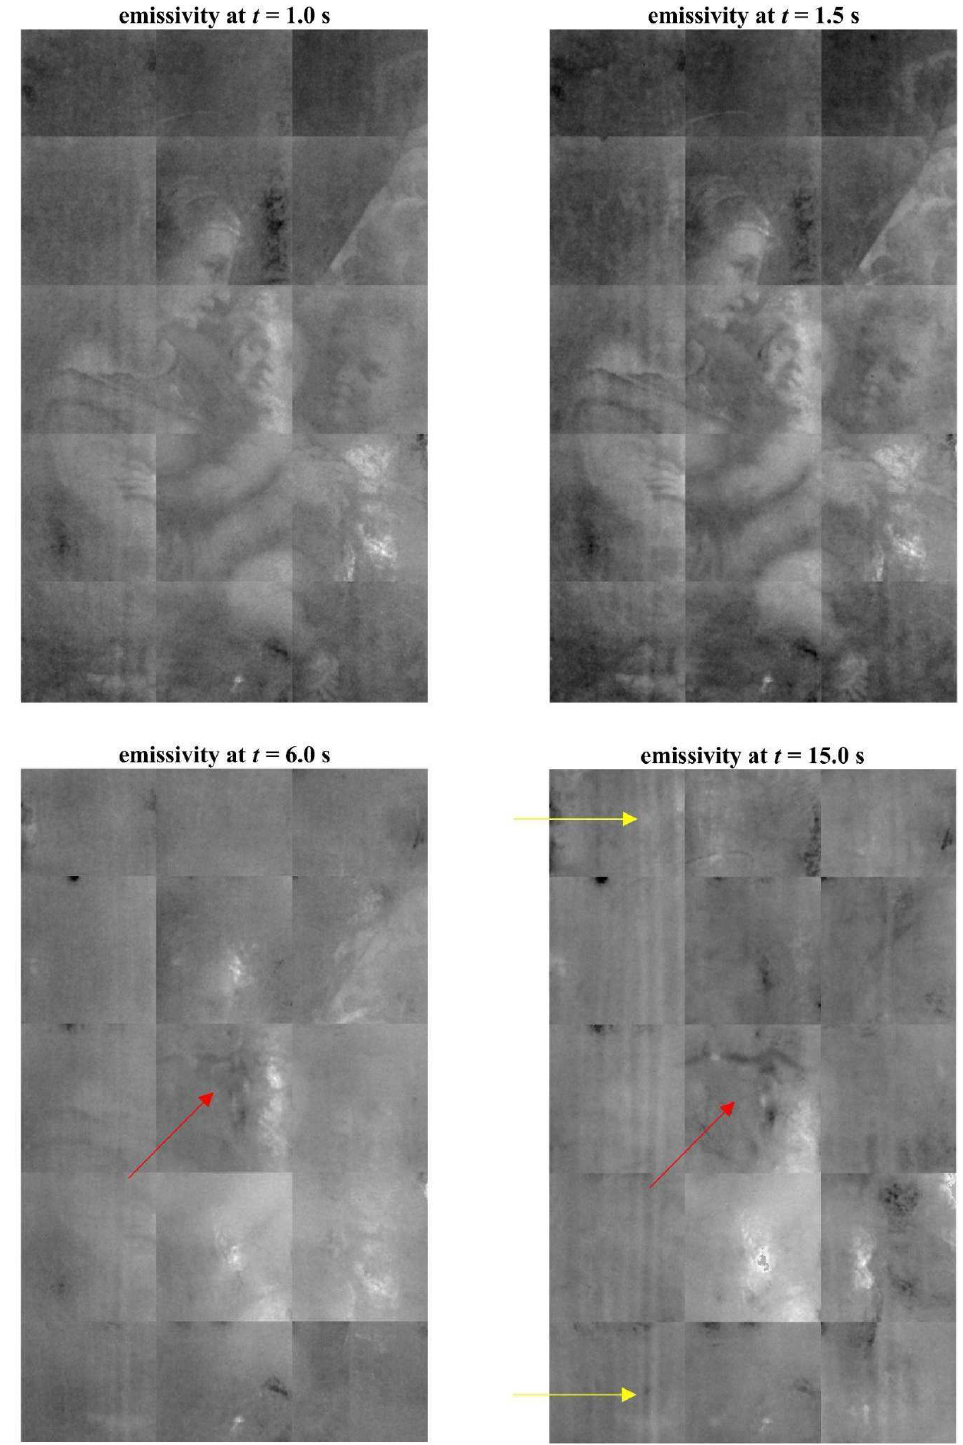
Figure 5. A series of thermograms at different time instants obtained by PuCT. A “Tau-shaped thermal signature is visible, starting from t = 6 s (red arrow). As a reference, the yellow arrows point out a single vertical wood grain signature. Note that other quasi-parallel grains are also well defined all across the inspected surface.